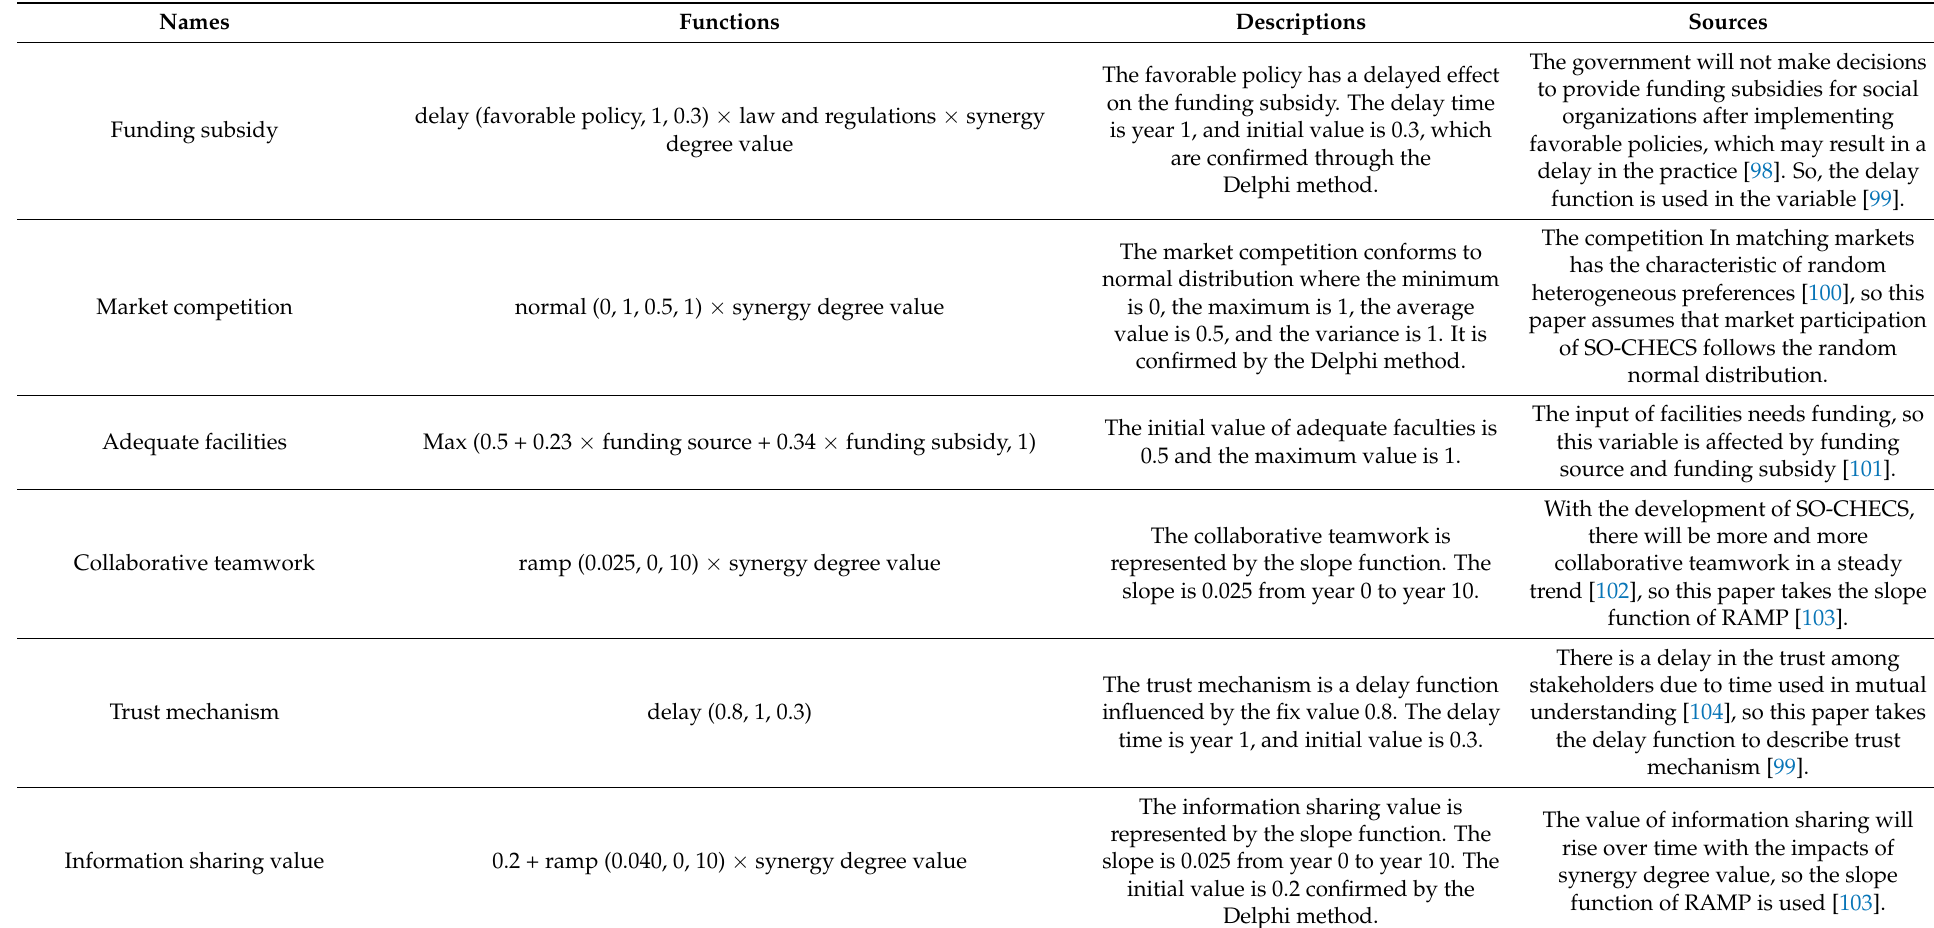
Table 2. The functions of main variables in the SD